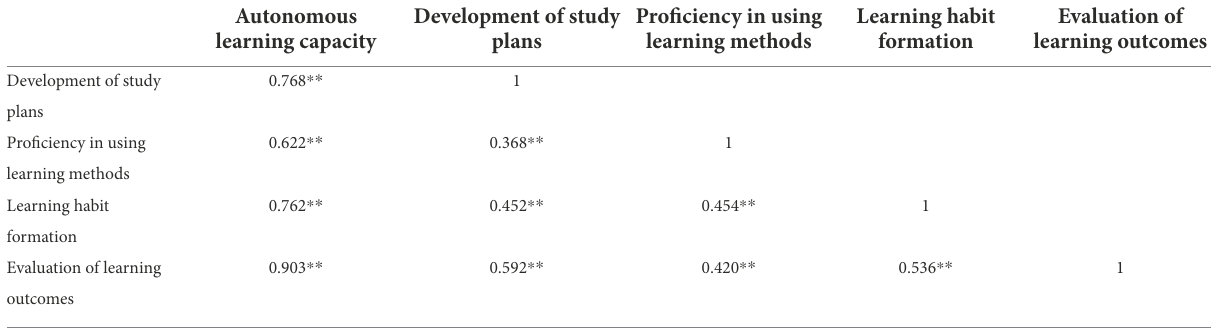
TABLE 3 Correlation between teachers’ autonomous learning capacity and its